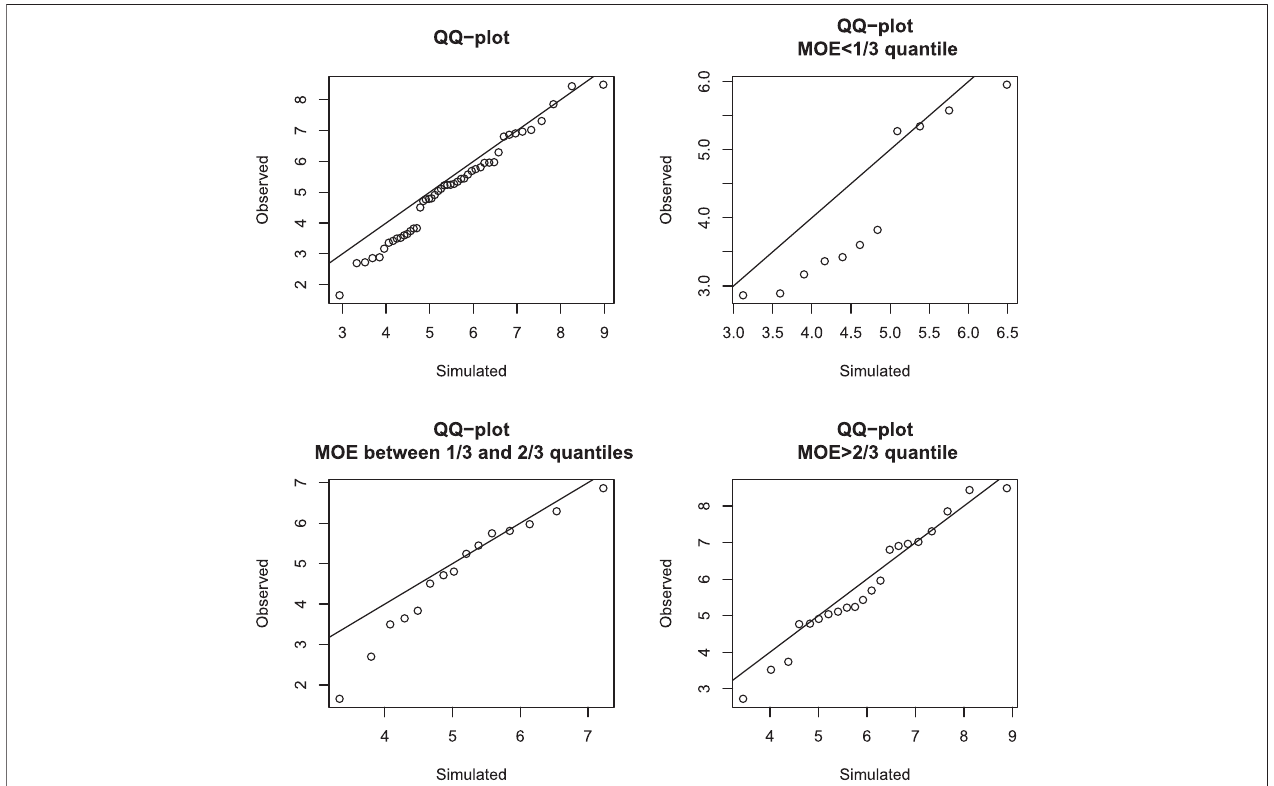
FIGURE 6 | Gaussian copula model and R40. Q-Q plot of observed residual UTS against simulated UTS with the identity line, given MOR greater than its 40 th quantile and MOE in different quantile intervals.